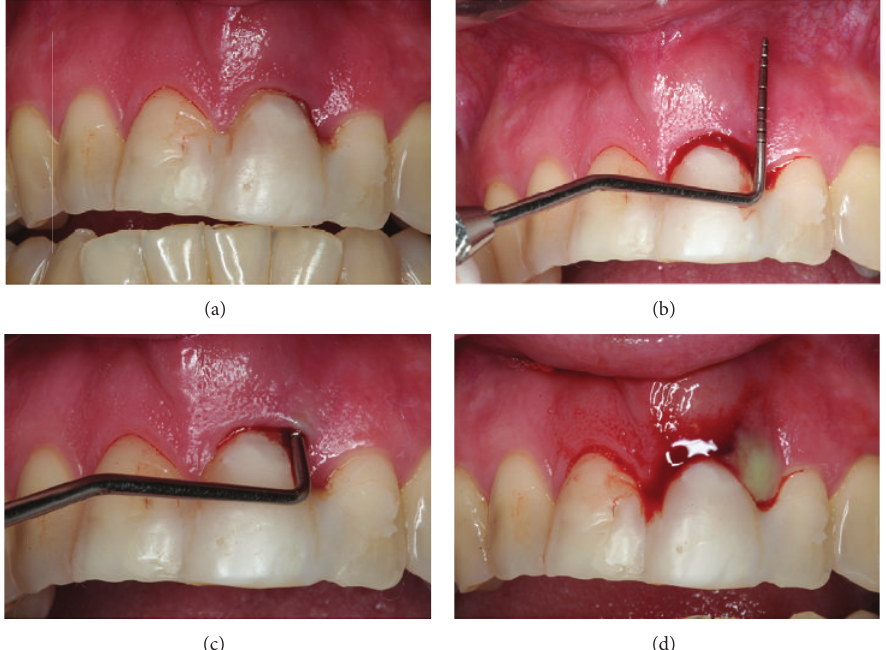
Figure 1: Pretreatment intraoral examination showing extensive periodontal pocket with 11mm of probing depth, bleeding, and suppuration on probe.